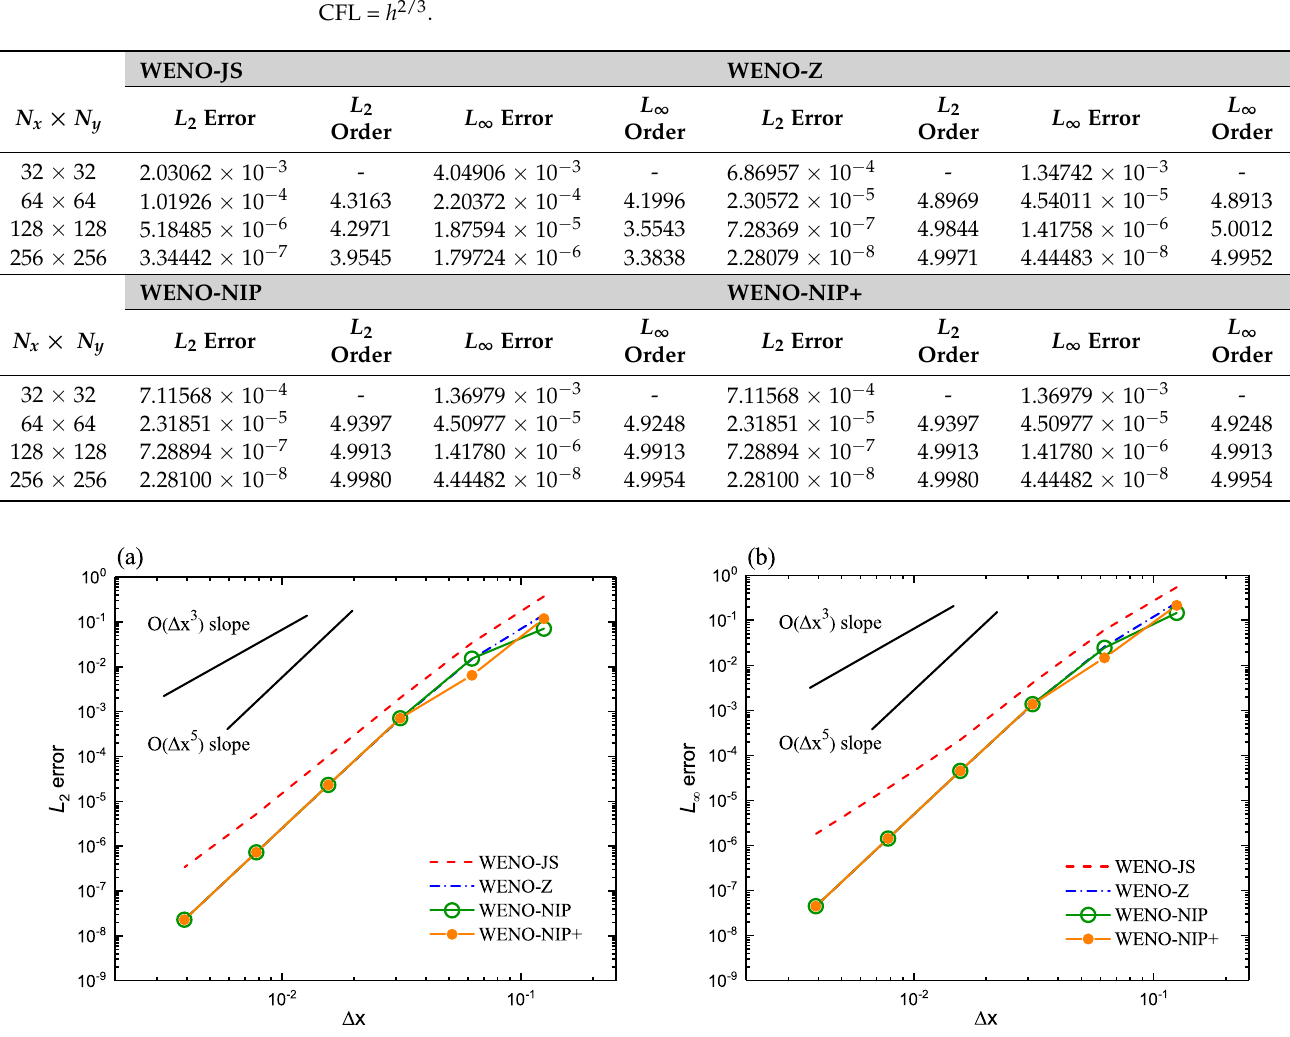
Figure 13. Plots of computing errors for different WENO schemes for Example 5: ( a ) L 2 -norm error; ( b ) L ∞ -norm